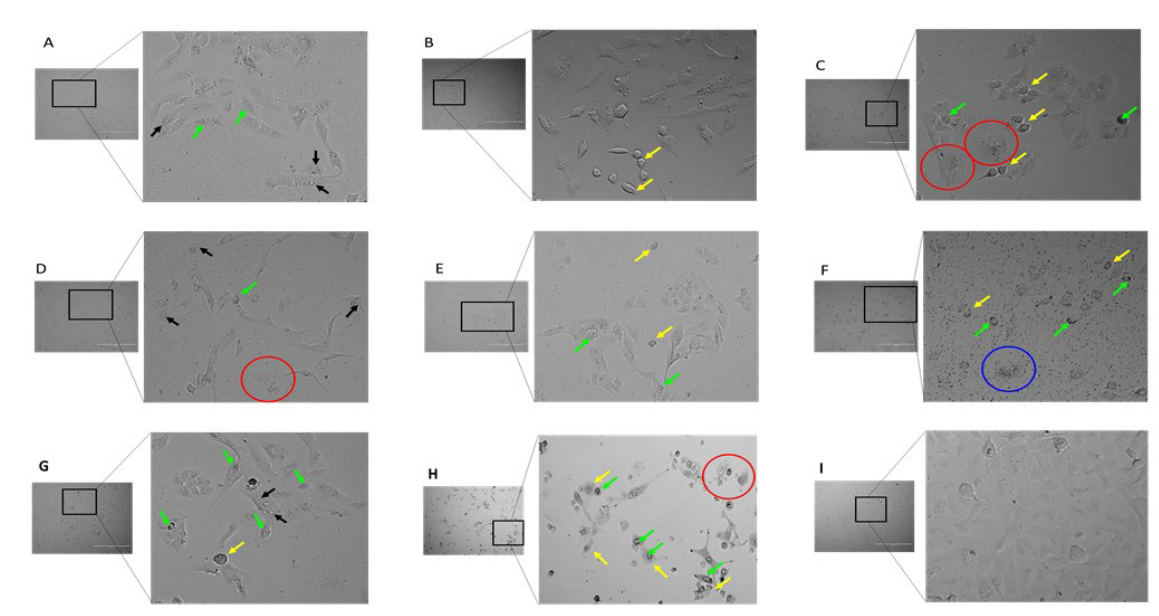
Figure 3. Photographs of A549 cells at 48 hours post-treatment with 200 µg/mL concentration of different AT005 spider venom fractions: (A) AT5-1, (B) AT5-2, (C) AT5-3, (D) AT5-4, (E) AT5-5, and (F) AT5-6, (G) Crude AT005, (H) 10 µg/mL cisplatin, and (I) untreated A549 cells. Arrow indicates different cytological features of A549 cells: black = membrane blebbing; yellow = cell shrinkage; green = nuclear condensation. Red circle = apoptotic cells; blue circle = lysed cell. Magnification: 40x; scale bars represent 40